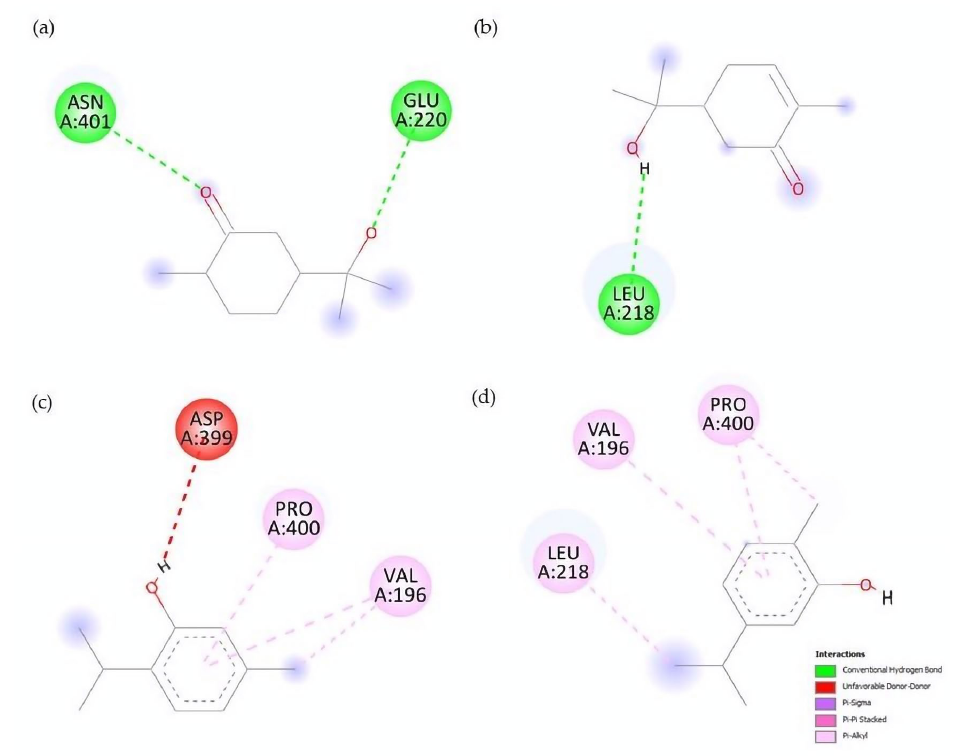
Figure 4. Display of AChE–ligand interactions: ( a ) hydrodihydrocarvone, ( b ) hydrodihydrocarvone, ( c ) thymol and ( d ) carvacrol. Docking on sterol carrier protein shows that monoterpenes and their derivatives can interact in regions including I19, R24, Q25, V26, and F105 residues. Table 7 shows the binding energies (ΔG) for each terpene evaluated. Compounds are listed according to their binding energy to highlight those that had more favorable values. After the phenolic compounds, γ -Terpinene and limonene were the monoterpenes with the most efficient affinity energy, while hydrocarvone and hydrodihydrocarvone were the compounds with lower energy values. The conformation of limonene and γ -terpinene in the active site of SCP-2 can be seen in Figure 5. A visualization of the interactions that take place between the compounds with the highest affinity and the amino acid residues is observed in Figure 6. Table 7. Docking results on sterol carrier protein (SCP-2) of Ae. aegypti